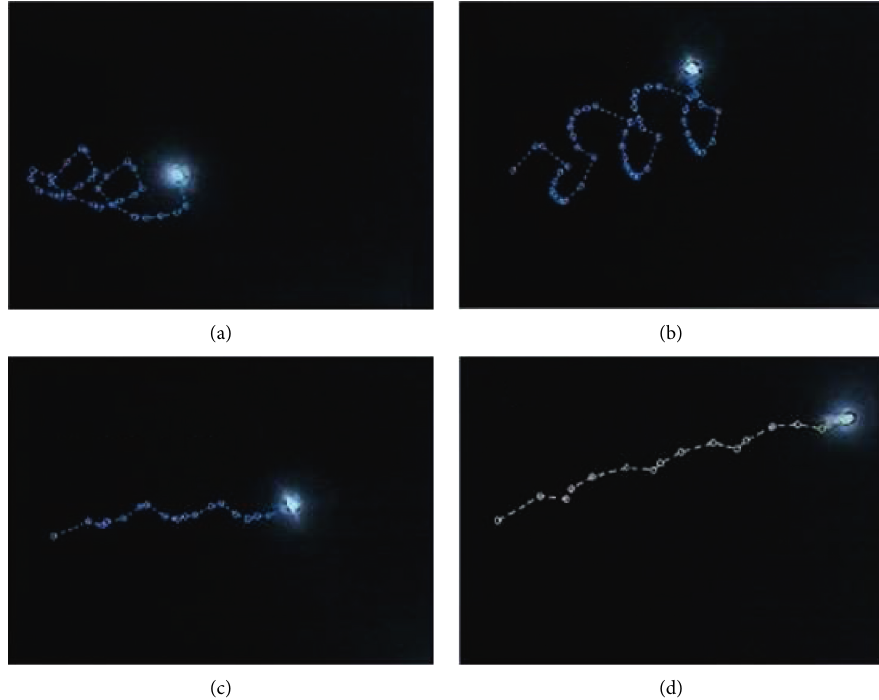
Figure 6: Images of trajectory paths in different generations. As the number of generations increases, the line’s length and smoothness improve. (a) Gen 1. (b) Gen 4. (c) Gen 10. (d) Gen 15.